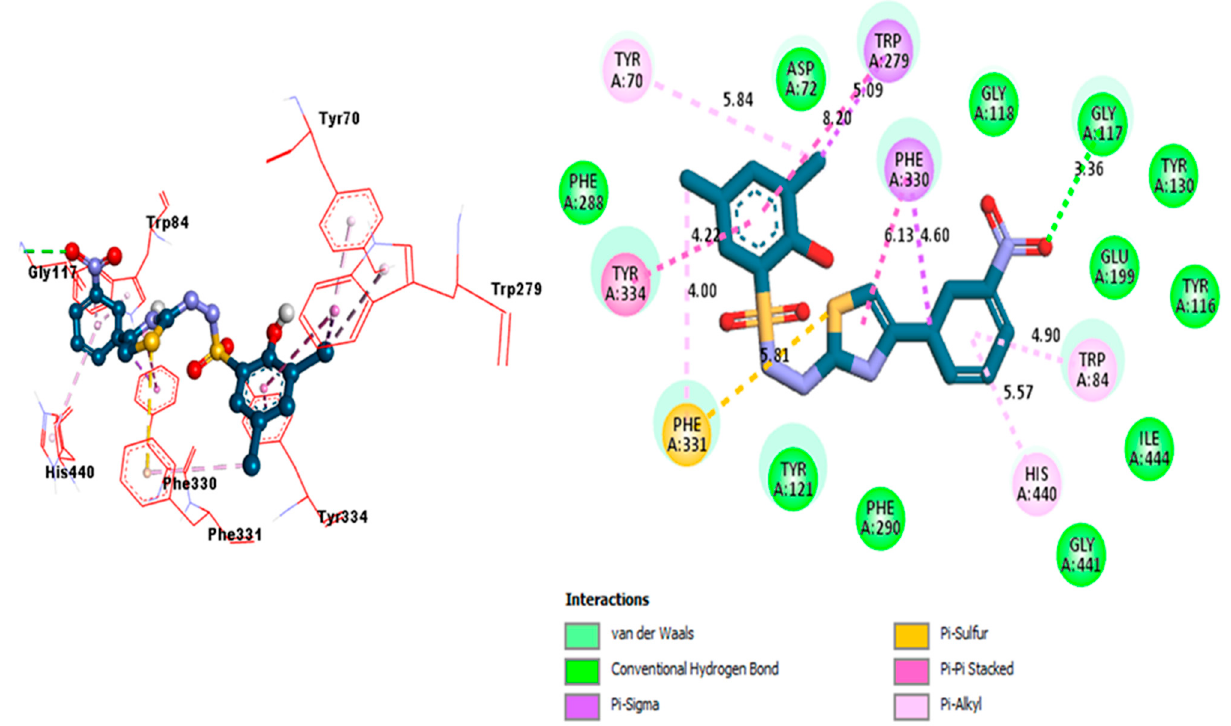
Figure 9. Representation of the PLI profile for compound 1 against AChE.